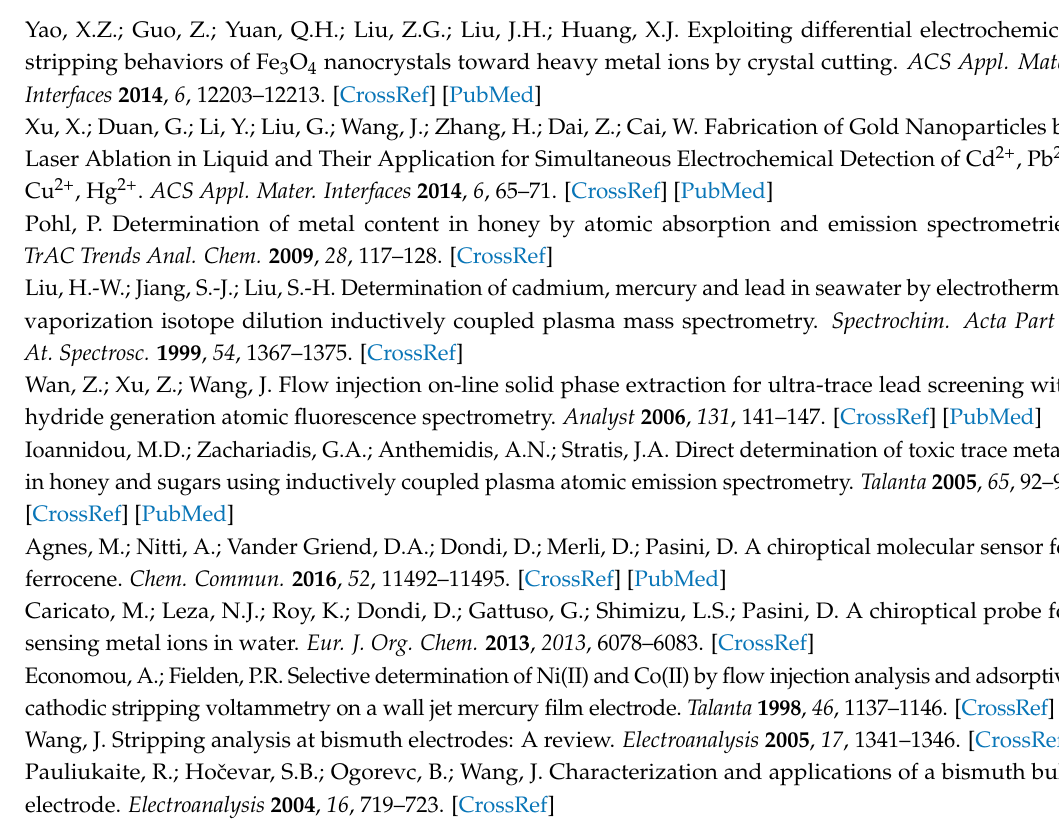
Figure S1: SWASV responses of S-TiO 2 , I-TiO 2 samples, Table S1: Comparison of electrochemical performance of nanomaterials modified